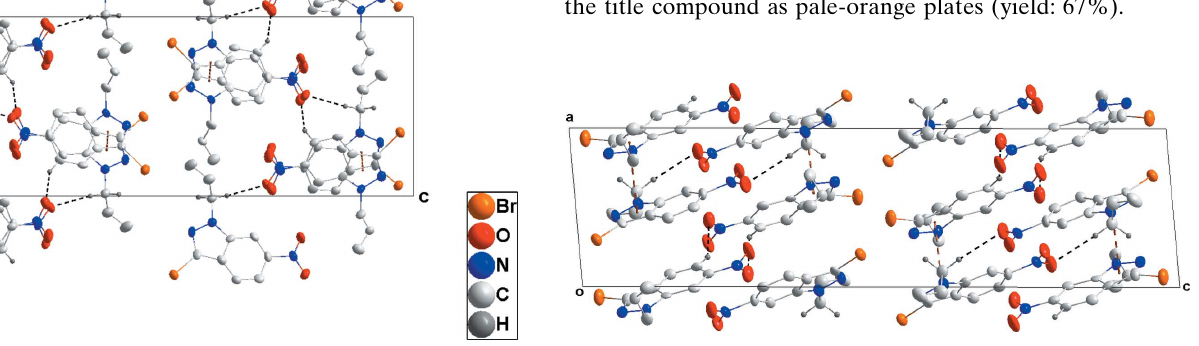
Figure 3 Packing viewed along the a -axis direction with intermolecular inter- actions shown as in Fig. 2